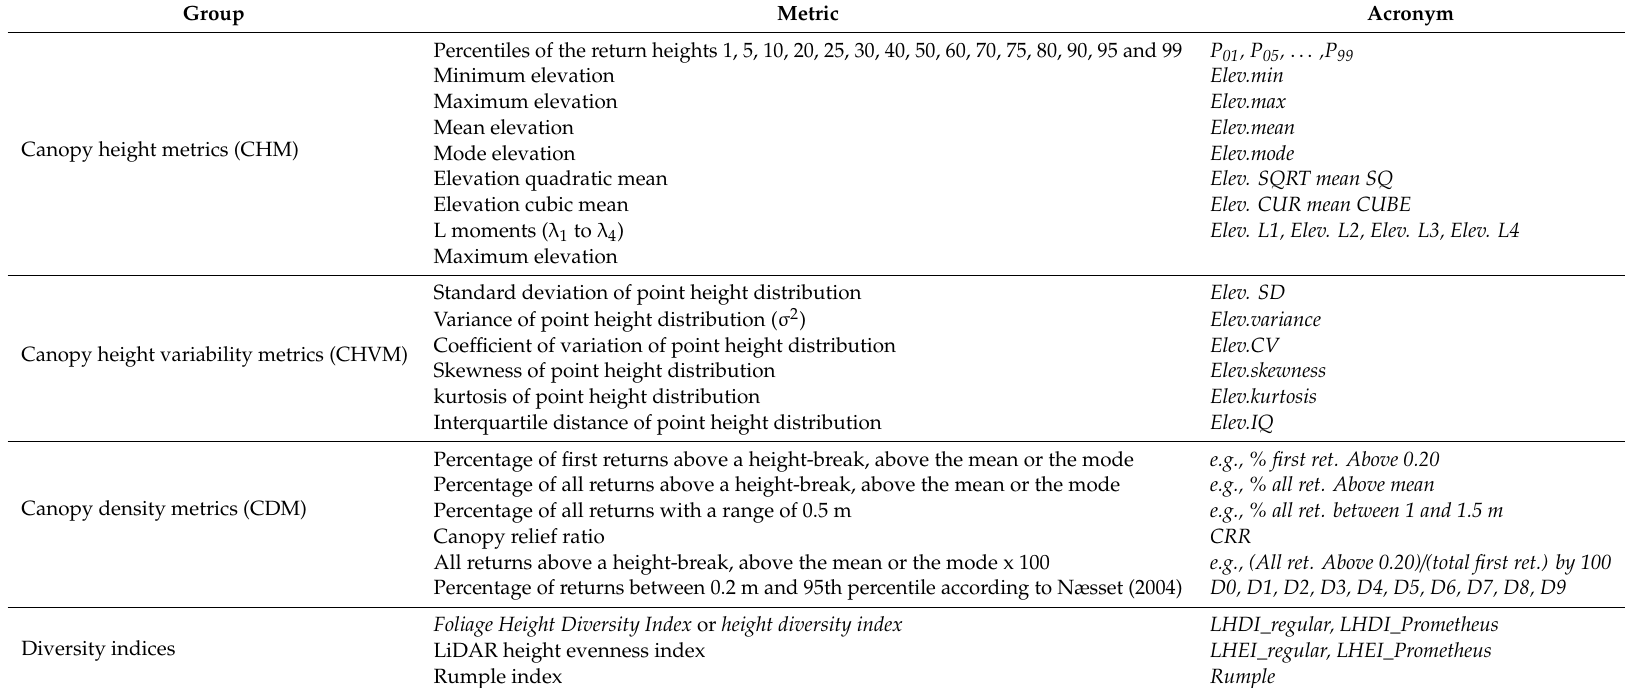
Table A1. Statistical metrics derived from the ALS point